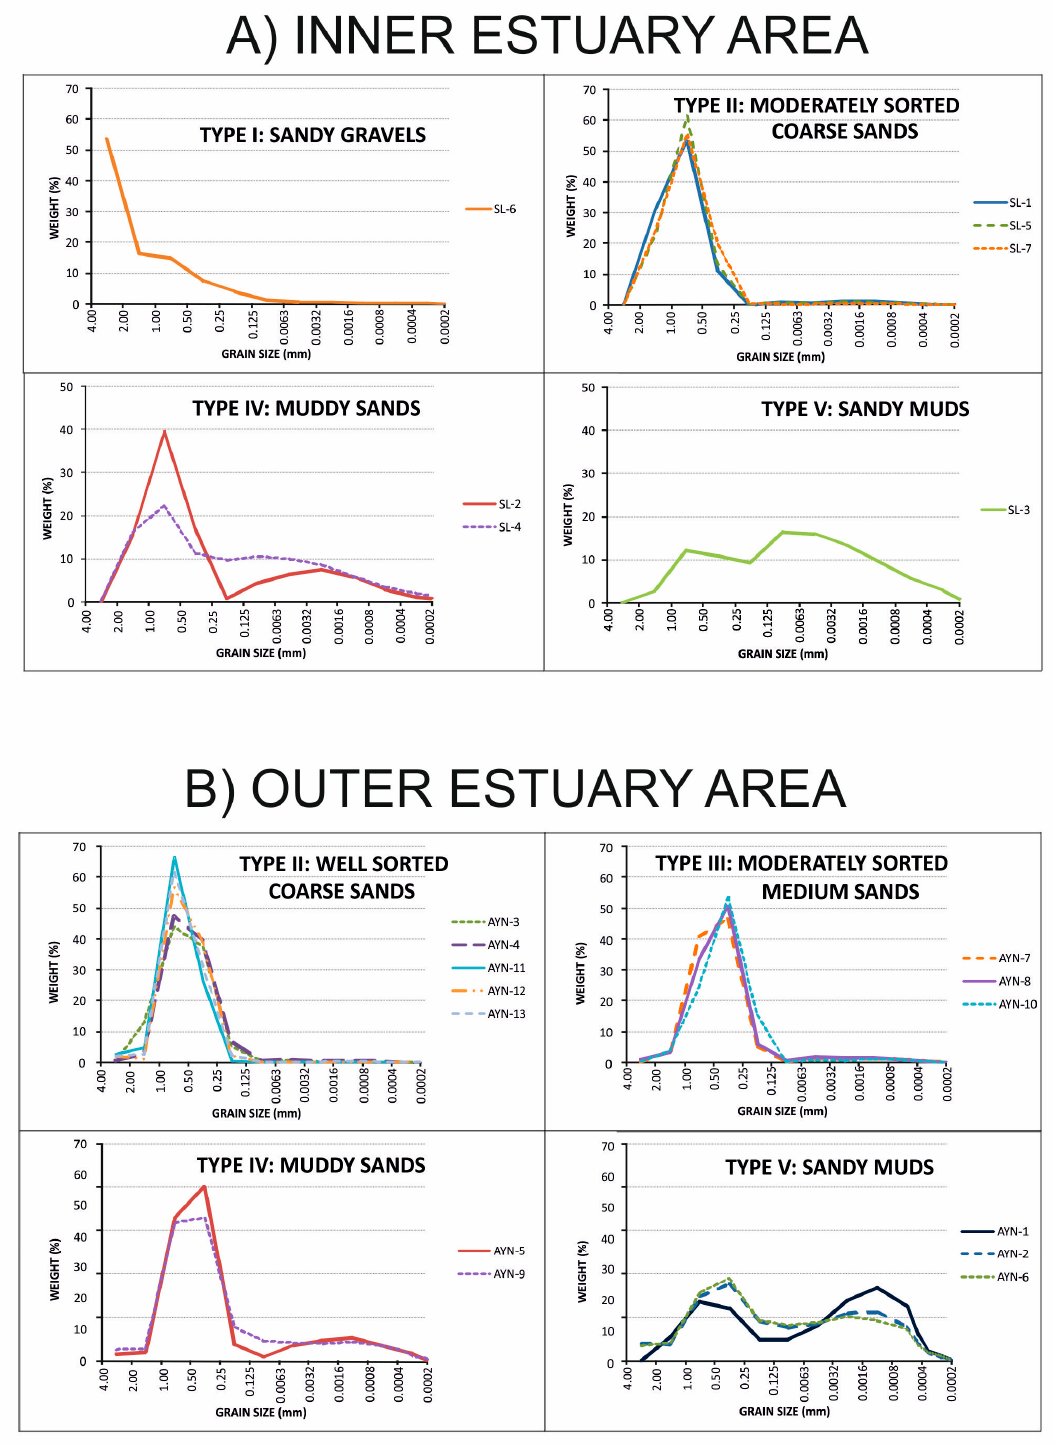
Figure 4. Types of grain size distribution within the ( A ) inner (fluvial) and ( B ) outer (marine) studied areas.